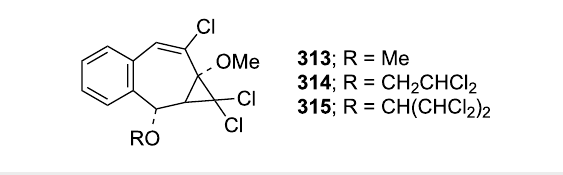
Figure 13: Unexpected byproducts 313 – 315 during synthesis of chlorobenzotropone 309